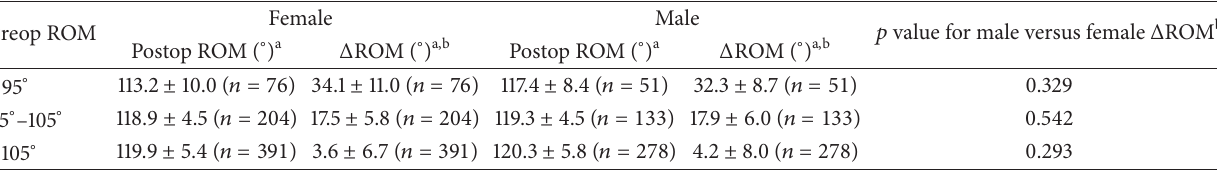
Table 4: Range of motion (ROM) comparisons after a minimum of 2 years.